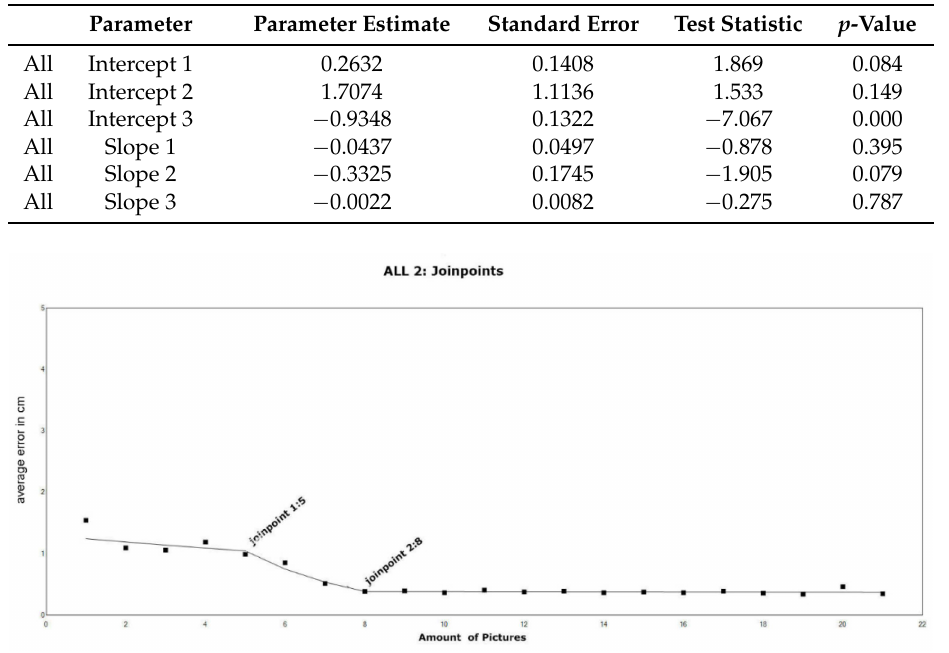
Table 4. Estimated regression coefficient (general parameterization).